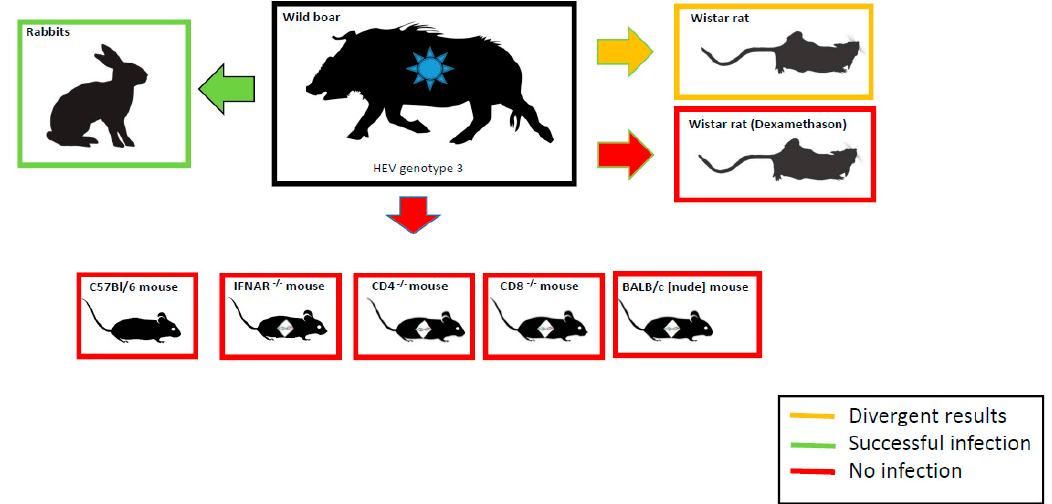
Figure 2. Experimental infection of wild boar-derived HEV-3 strain in wild-type and knockout mouse strains, Wistar rats, and rabbits. Details of the different experiments presented are given in the